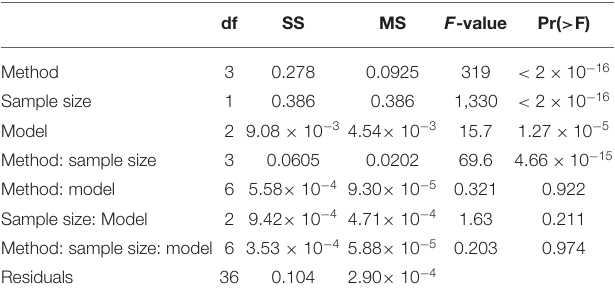
TABLE 2 | ANOVA table showing the significance of the statistical model, sample size, training set selection method, and interactions for the prediction accuracies of tuber length (TV